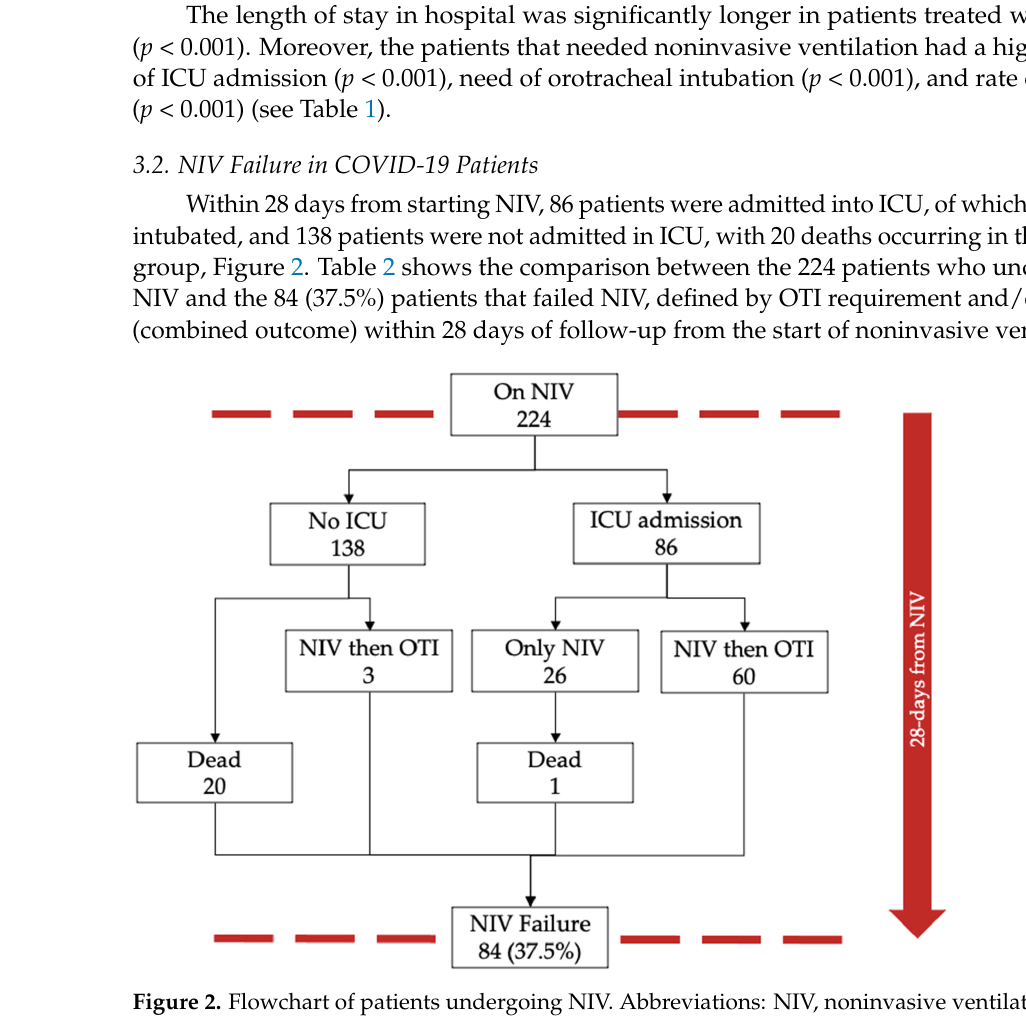
Figure 2. Flowchart of patients undergoing NIV. Abbreviations: NIV, noninvasive ventilation; ICU, intensive care unit; OTI, orotracheal intubation. Table 2. Unadjusted and adjusted predictors of NIV failure.